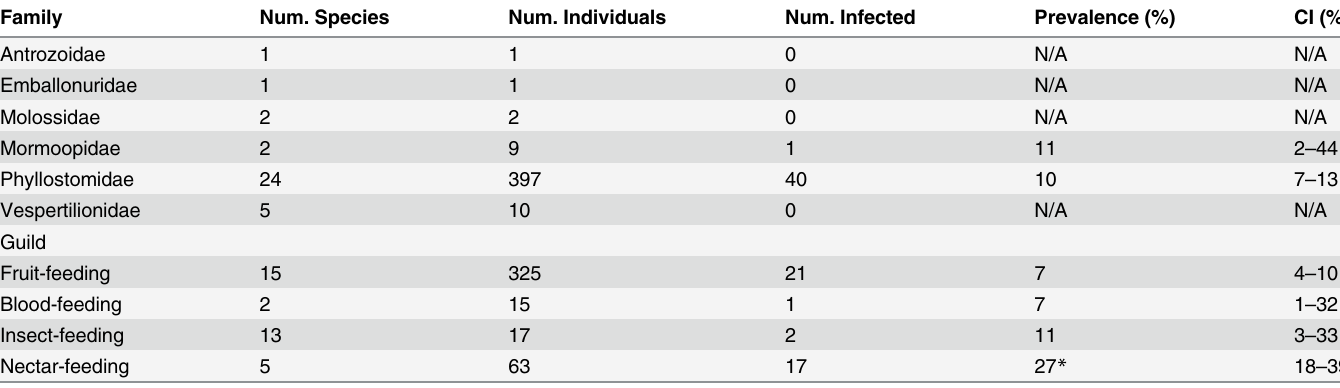
Table 1. 95% confidence intervals for number of species infected in different taxonomical families and trophic guilds. Family Num. Species Num. Individuals Num. Infected